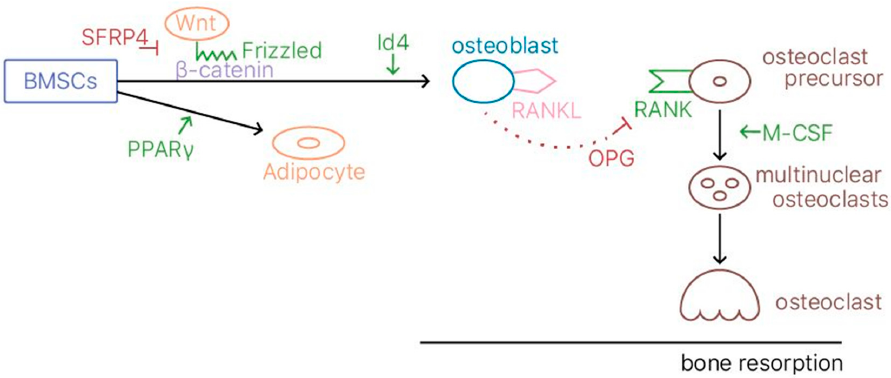
Figure 1. A summary of the molecular pathway underlying the action of osteoblasts, osteoclasts, and subsequent osteoporosis. 53